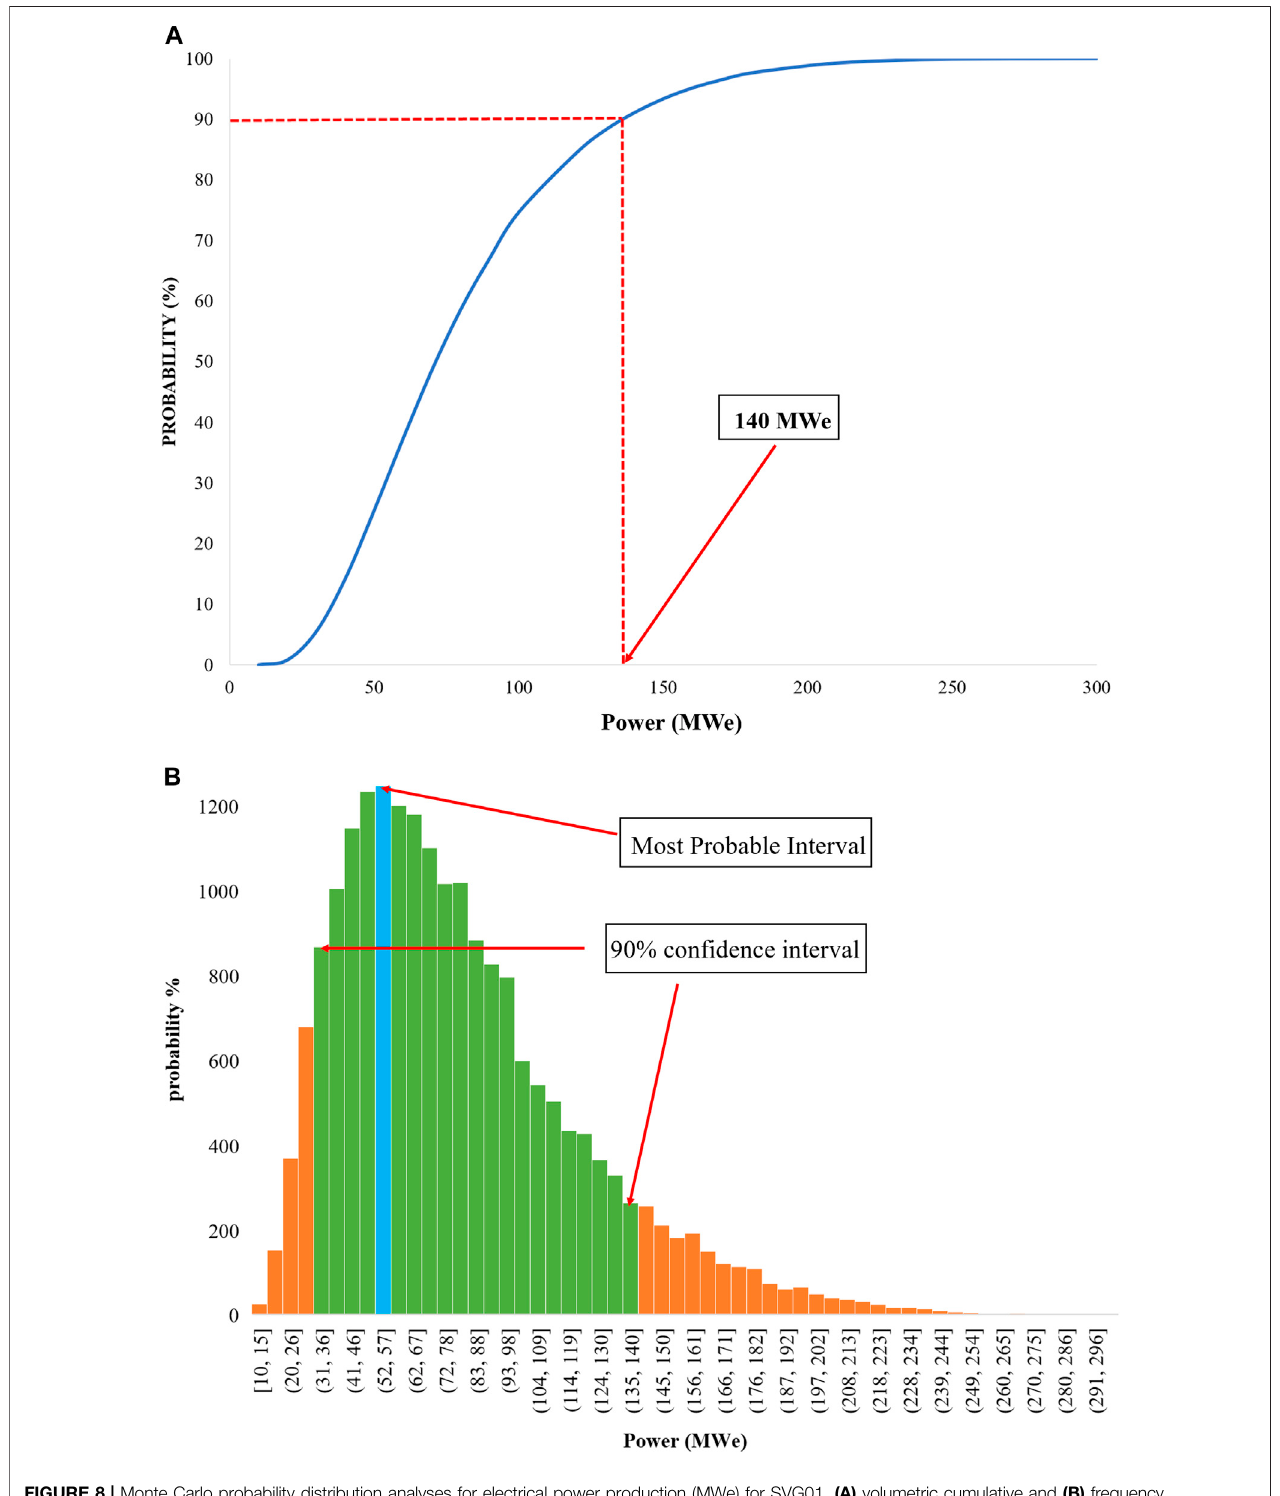
FIGURE 8 | Monte Carlo probability distribution analyses for electrical power production (MWe) for SVG01, (A) volumetric cumulative and (B) frequency.